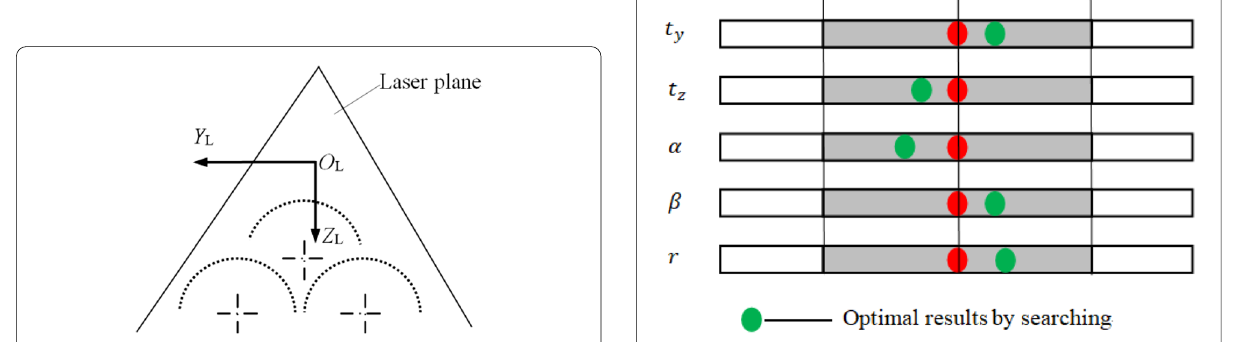
Figure 5 Schematic diagram of initial value, search range and optimal